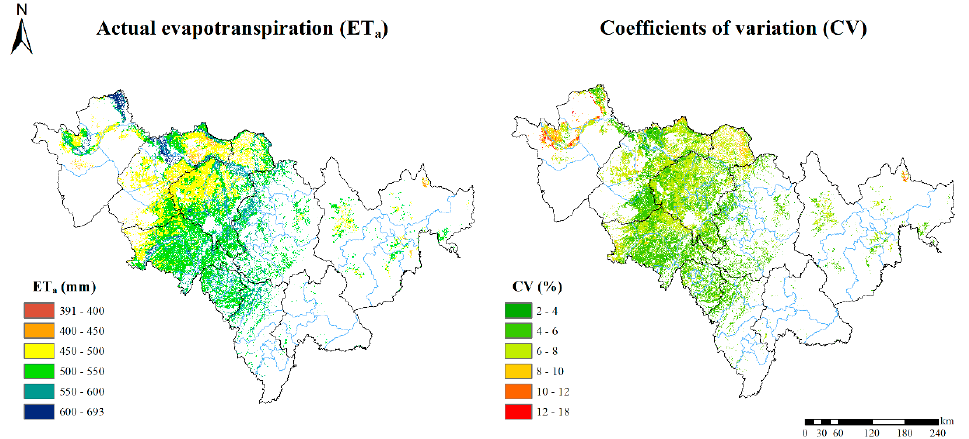
Figure 12. Multi-year average ET a (2001–2020) and its coefficient of variation (CV) during the growing period of spring maize in Jilin Province.